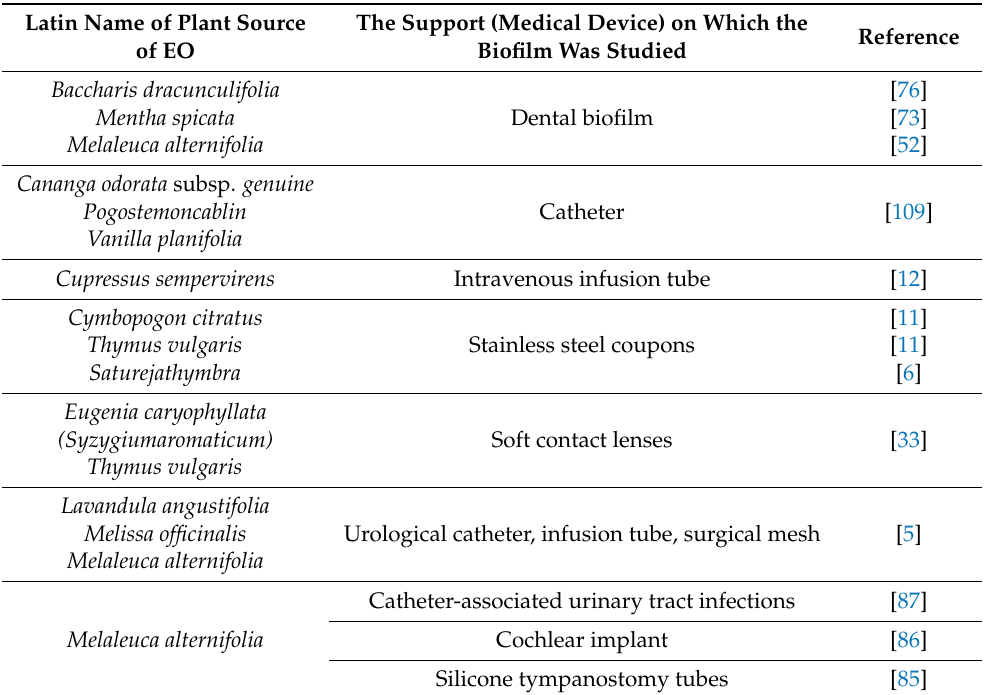
Table 2. The EOs studied in terms of microbial antibiofilm action formed on a medical device or live